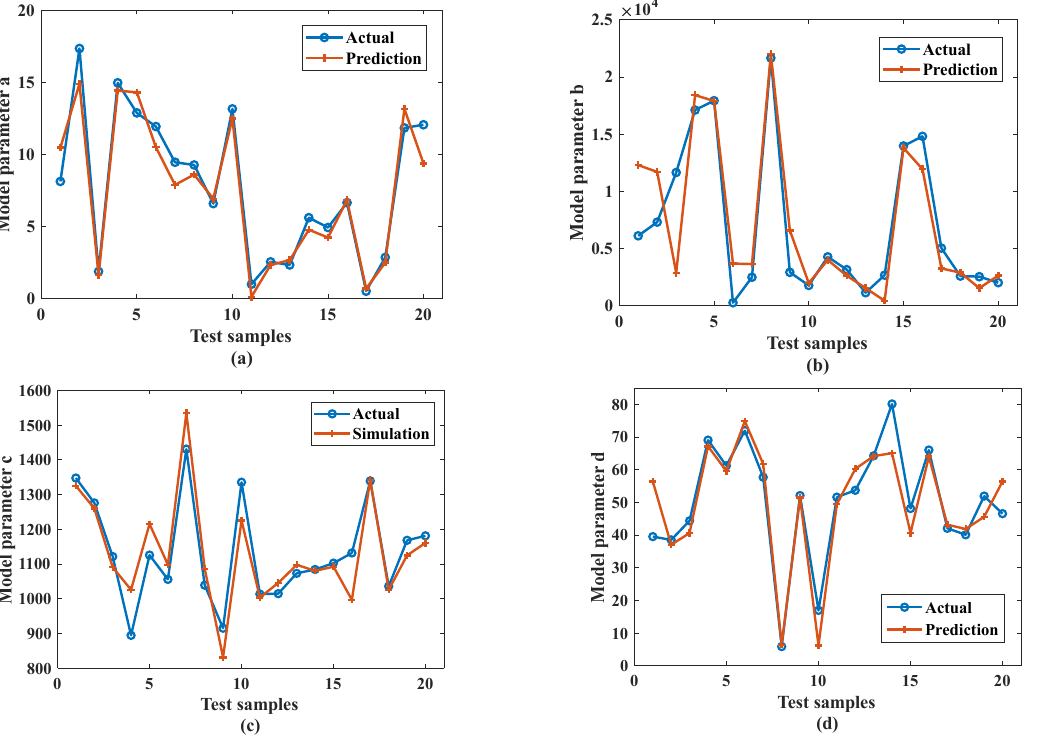
Figure 8. Prediction results of test samples based on the PCA–PSO–BP neural network: ( a ) model